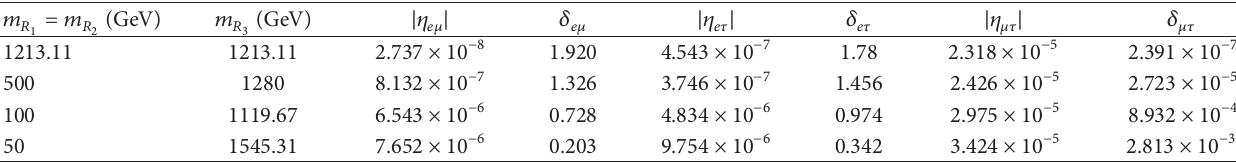
Table 1: Predictions of moduli and phases of nonunitarity matrix 𝜂 훼훽 as a function of allowed values of masses 𝑀 1 , 𝑀 2 , and 𝑀 3 . The Dirac neutrino matrix is the same as in [112].